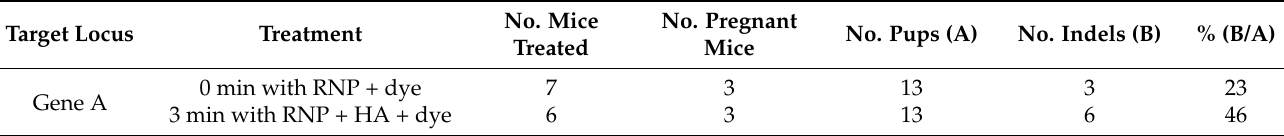
Table 1. i- GONAD 1 targeting Gene A at Day 0.5 of pregnancy (13:00 p.m.) using C57BL/6J mice.